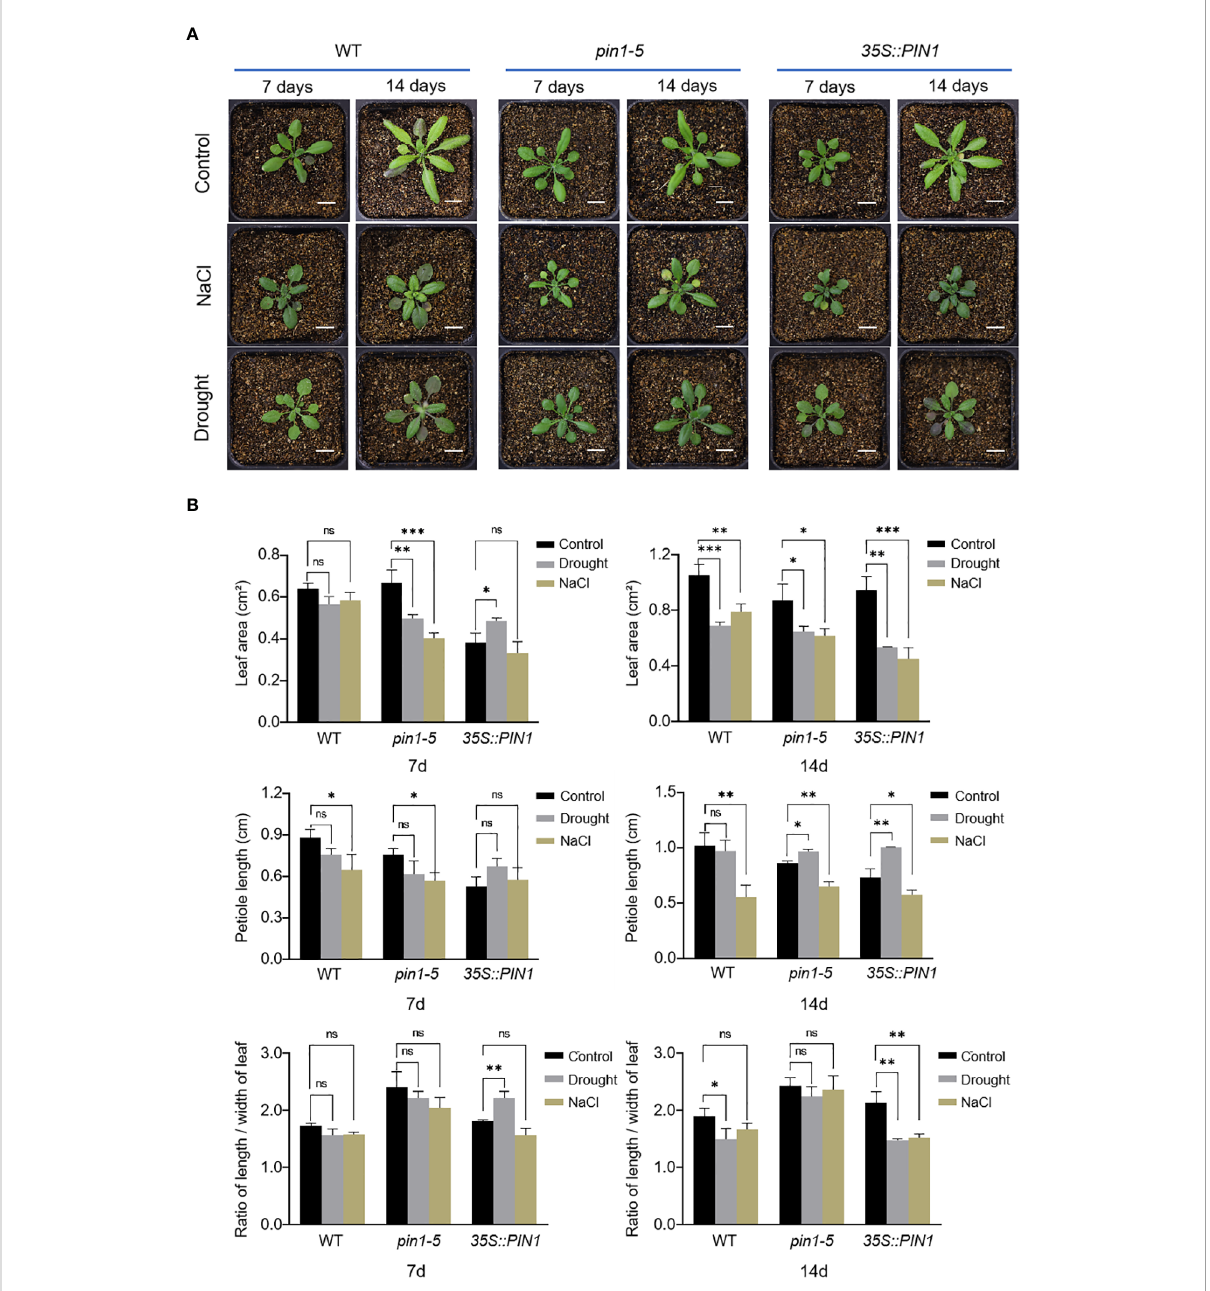
FIGURE 3 The leaves ’ shape changes in response to NaCl and drought stresses. (A) pin1-5 , 35S::PIN1 and WT were grown in soil for drought and NaCl treatment for 7 days and 14 days, respectively; the growth phenotypes were recorded by a camera; untreated seedlings were used as controls. Scale bar: 1 cm. (B) Statistical analysis of leaf area, petiole length and ratio of length/width of leaf in pin1-5 , 35S::PIN1 and WT seeding. The data were analyzed by one-way ANOVA following Brown – Forsythe test. ns: p > 0.05; *p < 0.05; **p < 0.01; ***p <